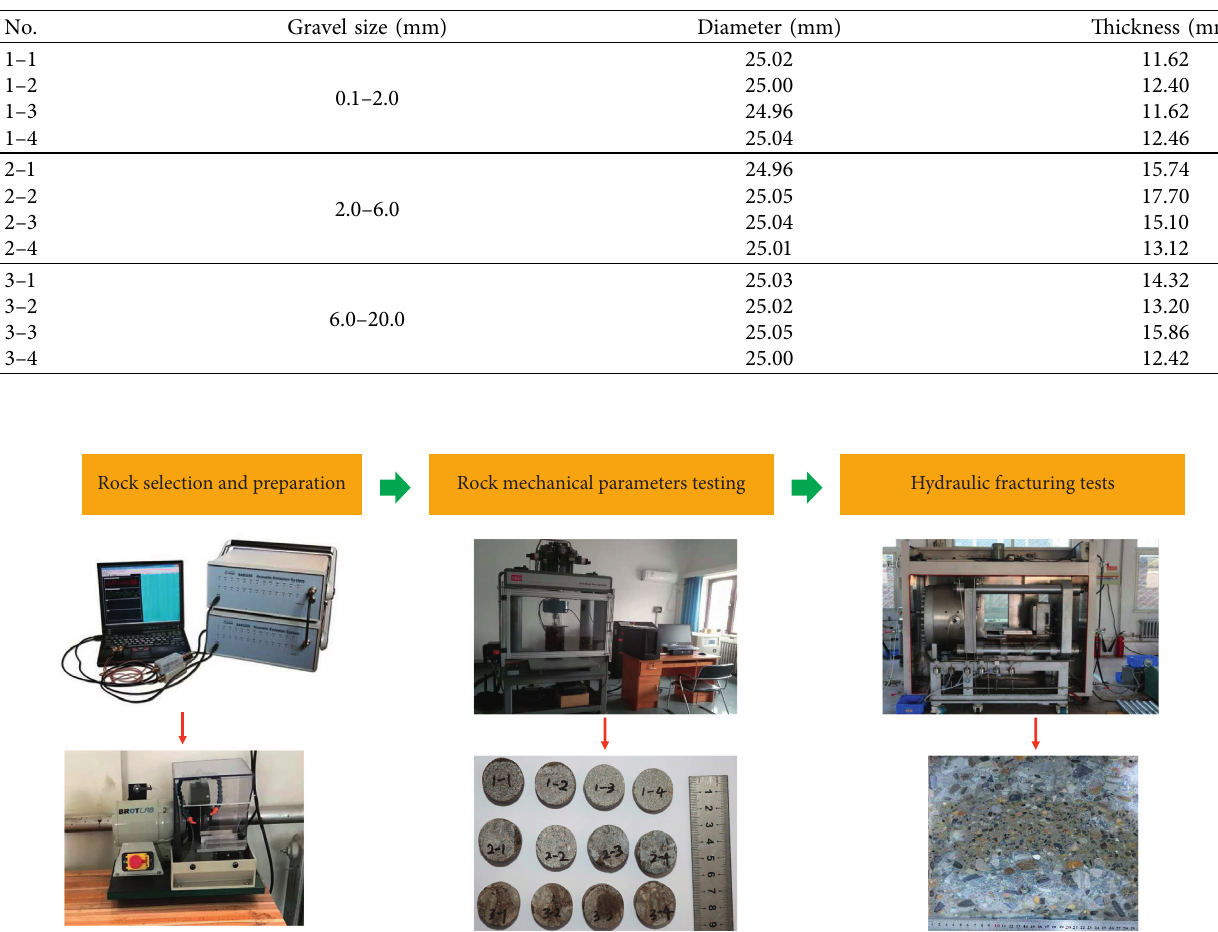
Figure 1: Experimental procedures and testing systems.